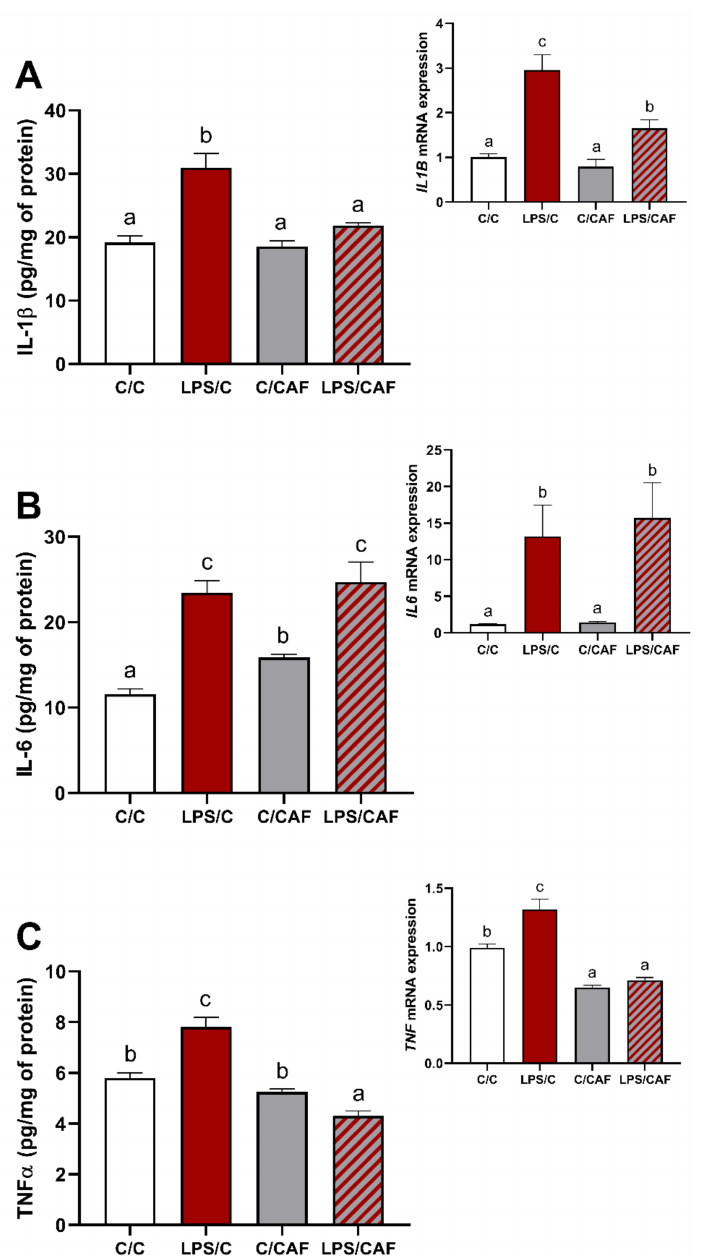
Figure 1. Mean ( ± SEM) concentration and gene expression (insert) of pro-inflammatory cytokines: interleukin 1beta ( A ), interleukin 6 ( B ) and tumor necrosis factor-alpha ( C ) in the ovine hypothalamus in saline- (C/C, 0.9% NaCl iv., white bars), lipopolysaccharide- (LPS/C, 400 ng/kg of body mass (bm.), iv., red bars), caffeine- (C/CAF, 30 mg/kg of bm., iv., grey bars) and LPS/CAF- (red-grey hatched bars) treated female sheep. Different letters indicate significant differences at p < 0.05, according to one-way ANOVA followed by Fisher’s post hoc test comparing groups with each